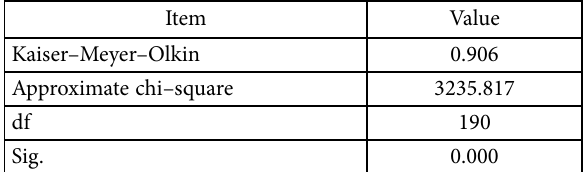
Table 7. Results of the Bartlett’s test